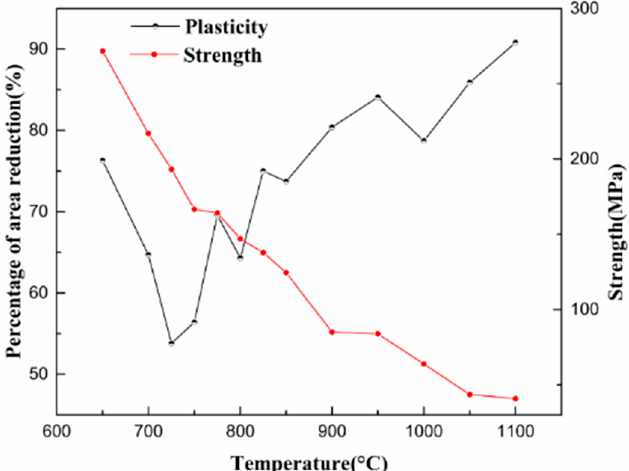
Figure 4. Thermoplasticity and strength curve of specimen.